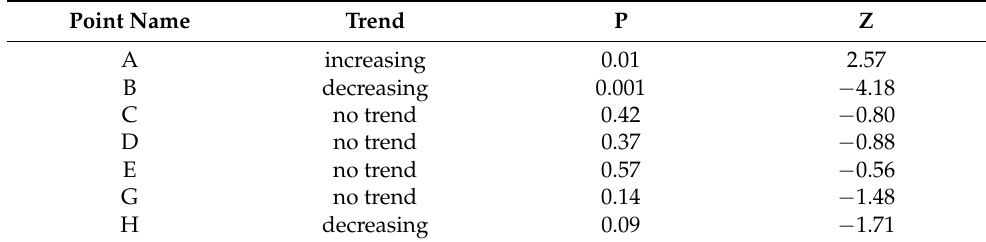
Table 4. M-K test for the SSC change at eight specific